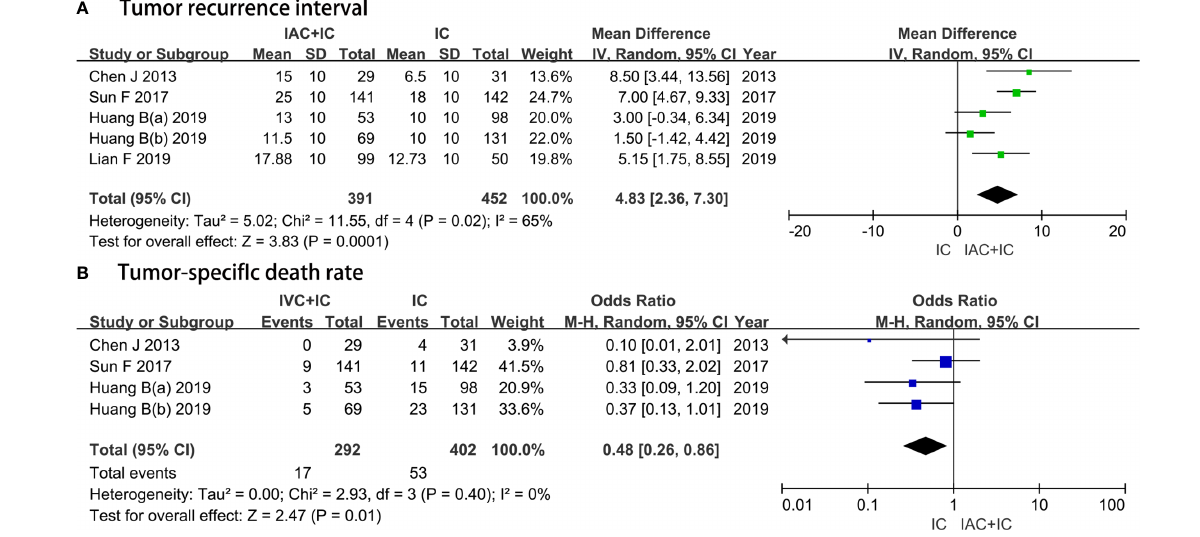
FIGURE 5 | Forest plots showing the result of (A) tumor recurrence interval and (B) tumor-speci fi c death rate. M – H, Mantel – Haenszel; CI, con fi dence interval; SD, standard deviation; IV, inverse variance; df, degrees of